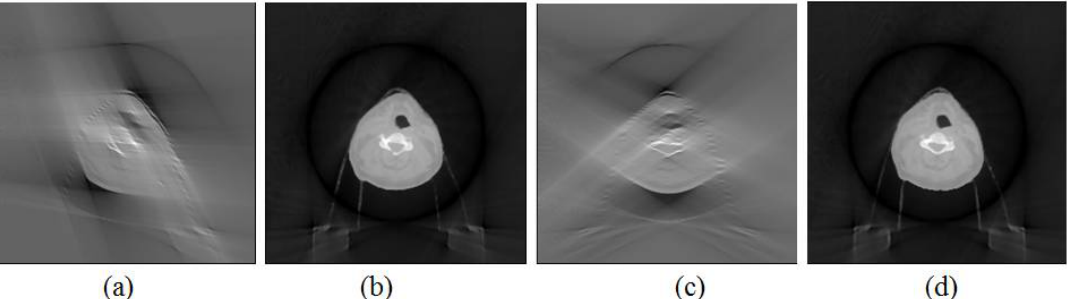
Figure 5. The image reconstructed with different scan orientations with the FDK and proposed methods. ( a ) Image reconstructed with 45° scan orientation with FDK method. ( b ) Image recon- methods. ( a ) Image reconstructed with 45 ◦ scan orientation with FDK method. ( b ) Image recon- structed with 45° scan orientation with the proposed method. ( c ) Image reconstructed with 90° scan structed with 45 ◦ scan orientation with the proposed method. ( c ) Image reconstructed with 90 ◦ orientation with FDK method. ( d ) Image reconstructed with 90° scan orientation with the proposed scan orientation with FDK method. ( d ) Image reconstructed with 90 ◦ scan orientation with the method. proposed method.